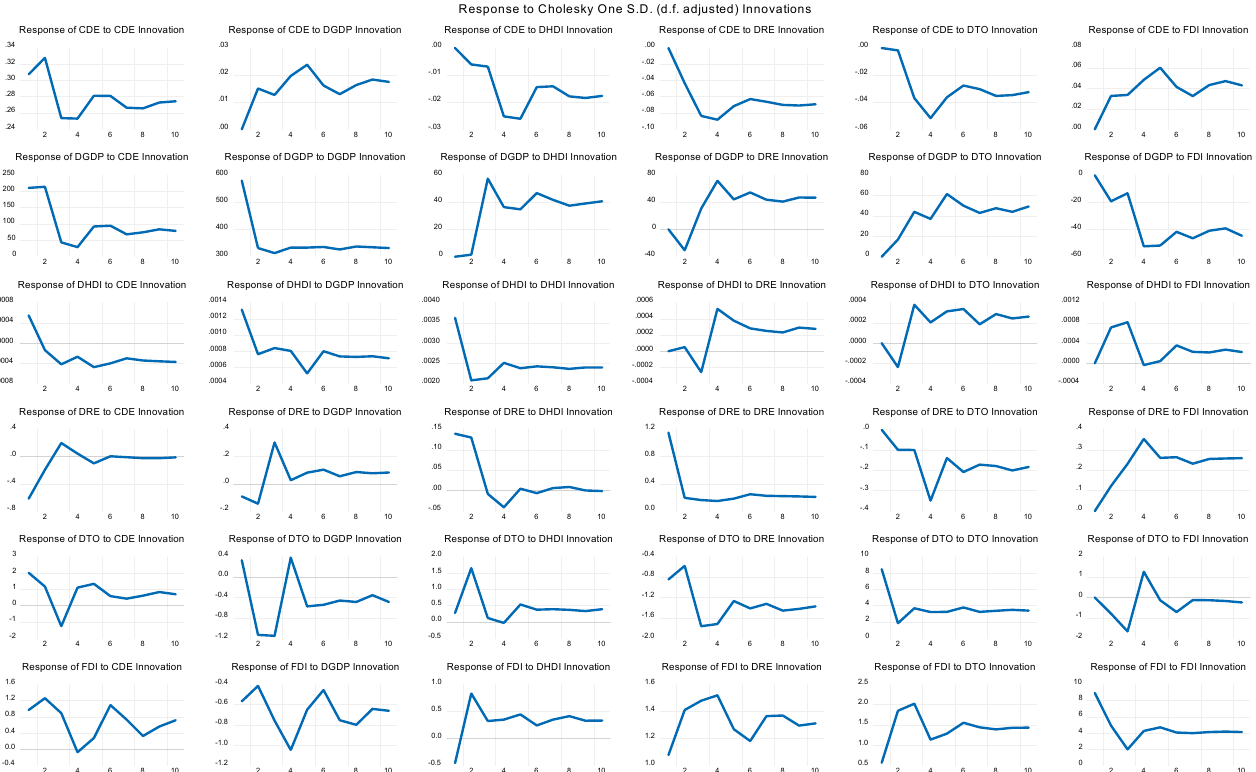
Figure 3. Impulse Response Function.